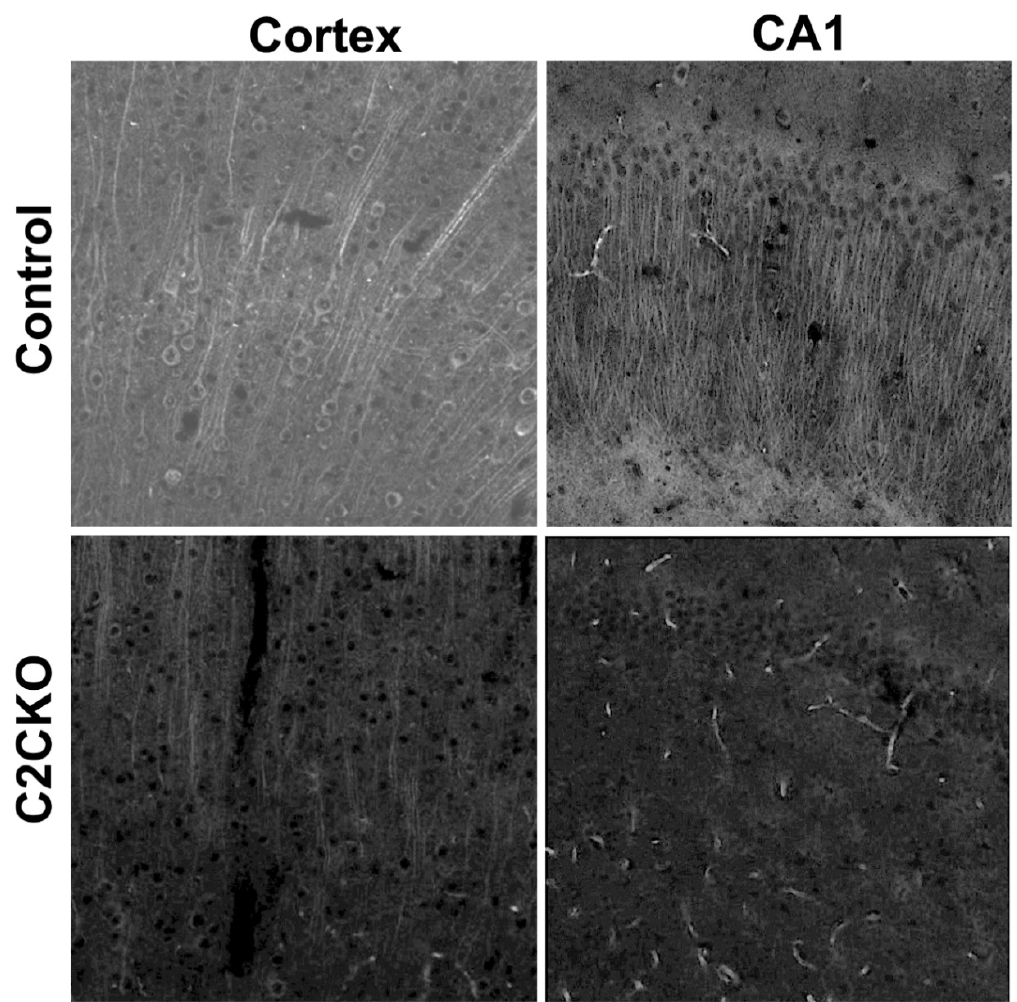
Figure 1. Calpain-2 deletion in cortex and hippocampal field CA1 in calpain-2 conditional knock-out (C2CKO) mice. Immunohistochemistry (IHC) with calpain-2 antibody (1:300; LS-C337641, LSBio) in cortex and CA1 of control (calpain-2 loxP) and C2CKO mice. Note the very large decrease in calpain-2 immunoreactivity in cortex and field CA1 of hippocampus. Scale bar: 50 µ m. Details for the methods can be found in the Supplementary